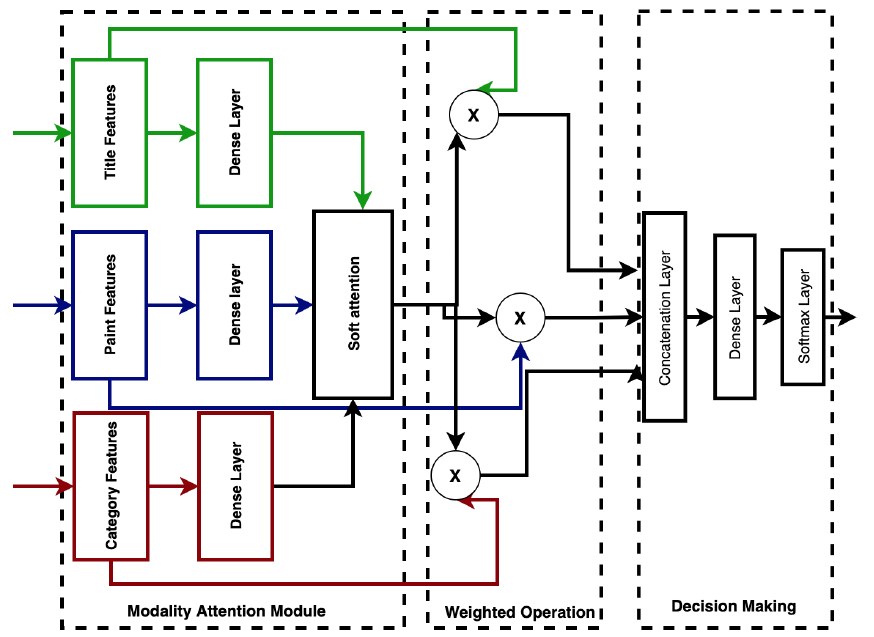
Figure 3. Weighted modality